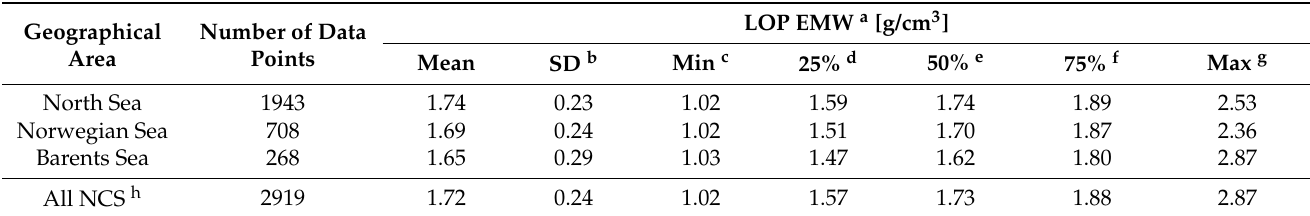
Table 1. Statistics of leak-off pressures in analysis.